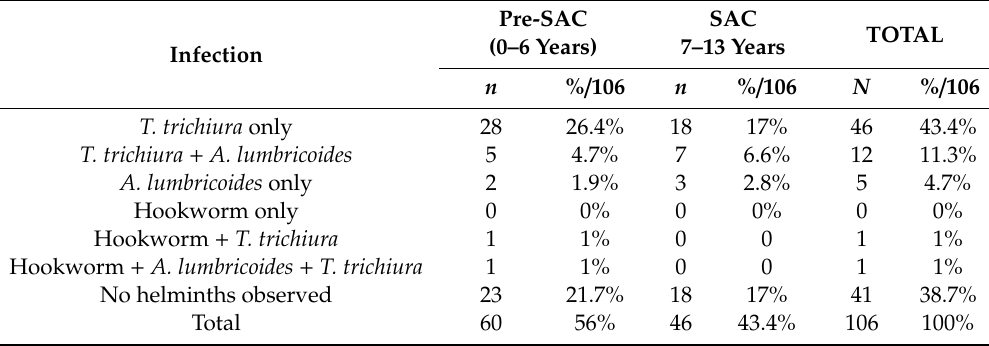
(Pre-SAC) and school-aged children (SAC) in La Hicaca, Yoro, Honduras ( n = 106). Pre-SAC SAC Infection